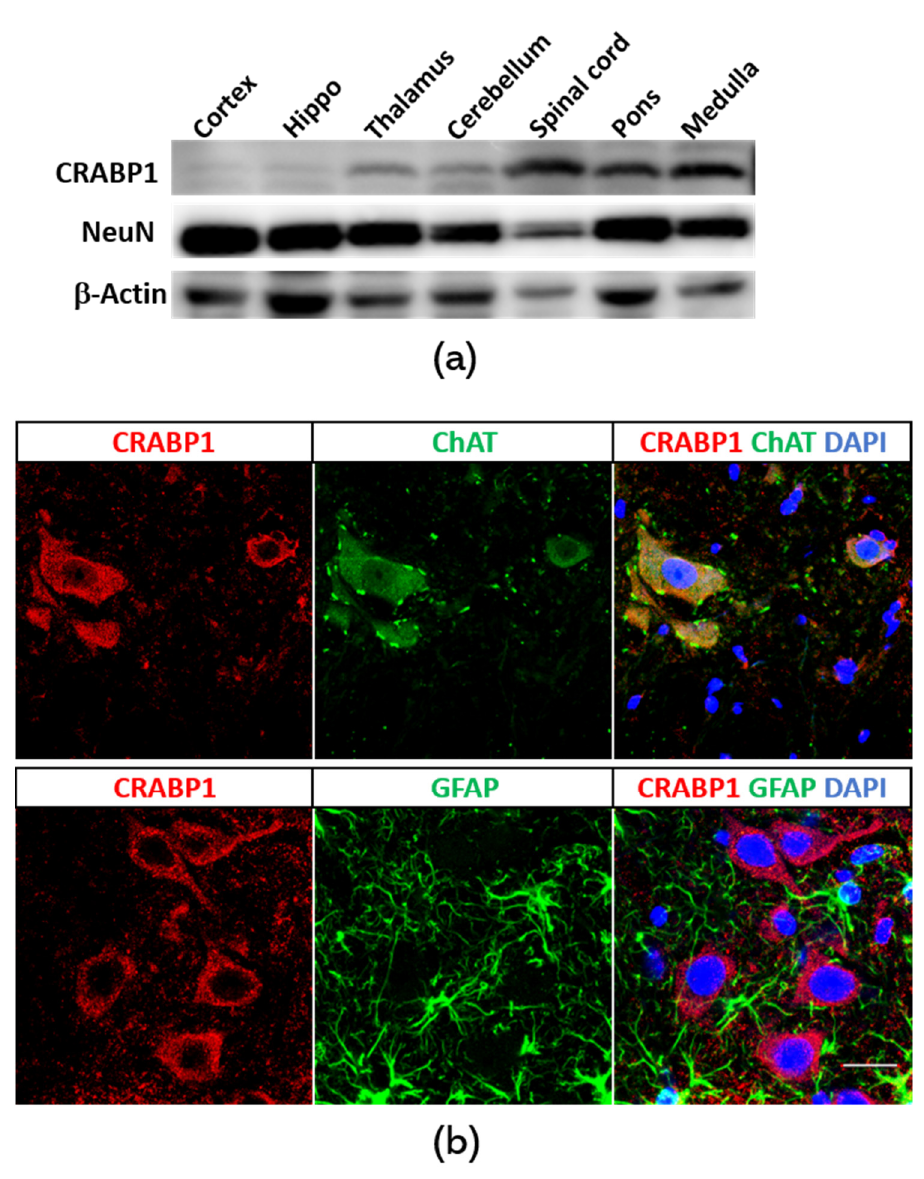
Figure 1. CRABP1 expression in the CNS. ( a ) Western blot analyses of CRABP1 in the CNS. ( b ) Confocal microscopy images showing signals of CRABP1 (red), spinal motor neuronal marker ChAT (green; upper middle), astrocyte marker (green; lower middle), and cell nuclei (DAPI). Scale bar = 20 µm.